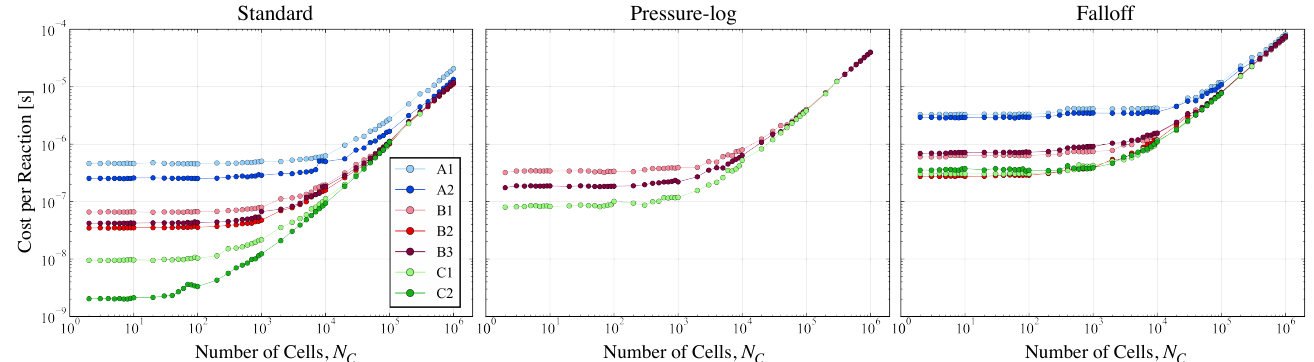
Figure 8. Cost per reaction for all mechanisms for: standard reactions ( left ); pressure-log reactions ( middle ); and falloff reactions ( right ). See Table 1 for mechanism